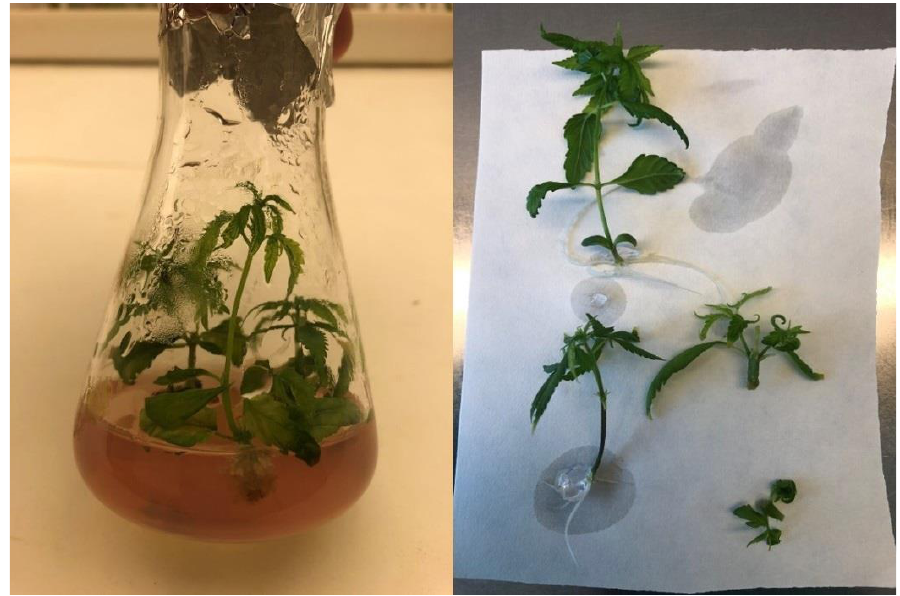
Figure 7. Multiplication of the ‘USO-31’ cultivar on ViVi 6 culture medium to achieve the required amount of biomass to establish the experiment with PEO-IAA.